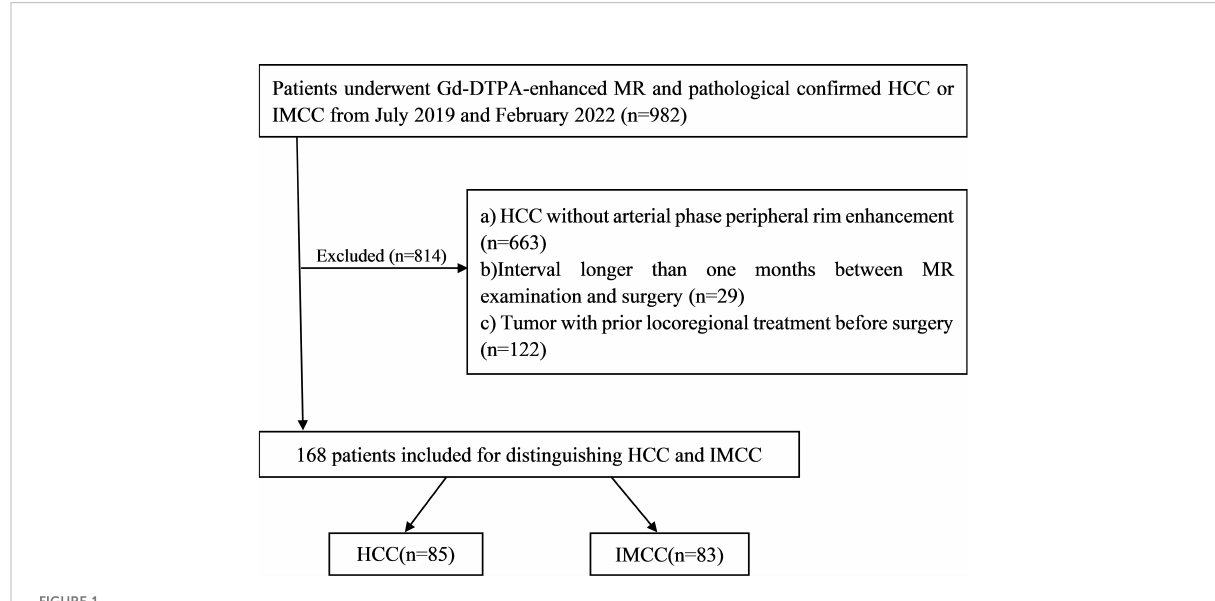
FIGURE 1 The work fl ow of patient selection for this